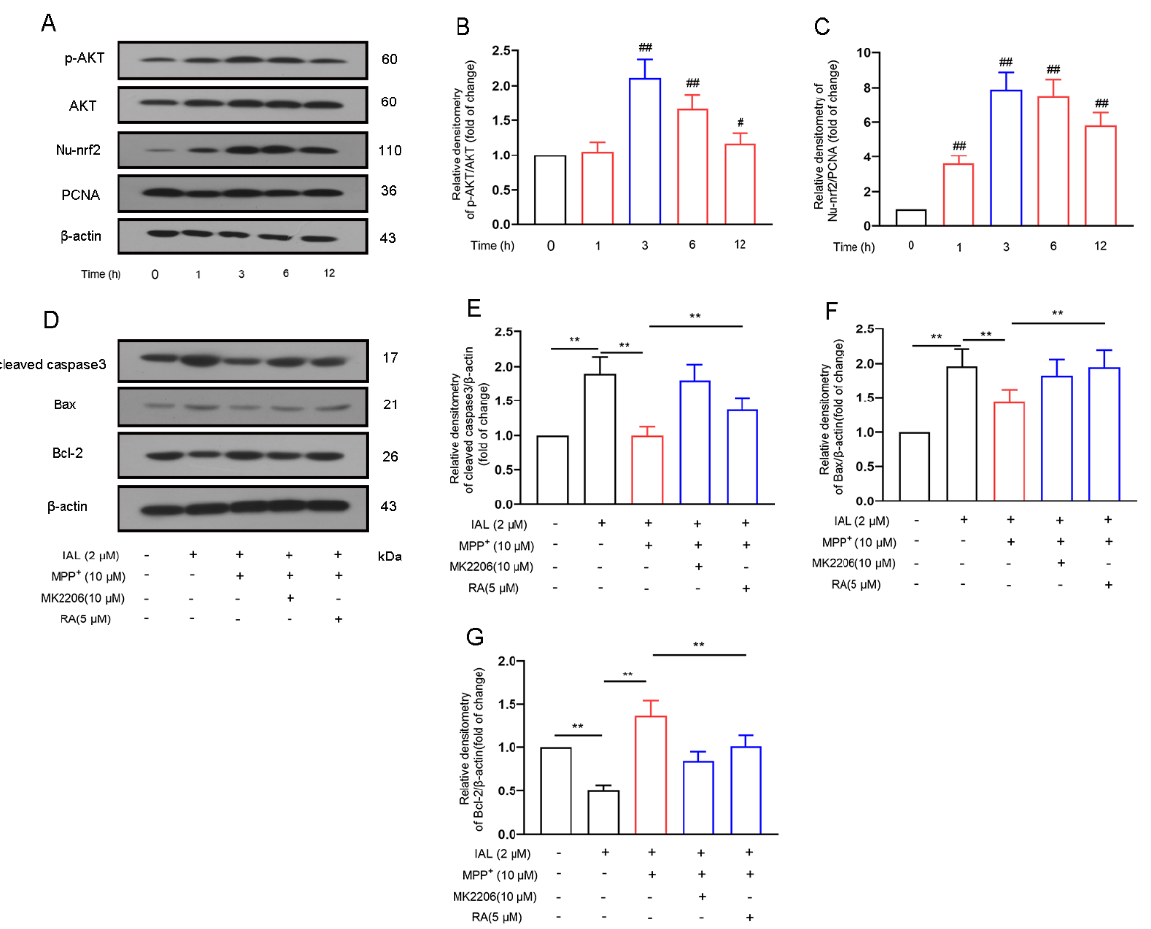
Figure 5. IAL treatment reduces MPP + -induced SN4741 apoptosis by activating AKT/Nrf2 pathway. ( A – C ) The effect of IAL on the AKT/Nrf2 pathway in SN4741 was analyzed with the Western blot method. ( D – F ) After pretreatment of cells with MK2206 and RA, the effect of IAL on apoptosis-related proteins in SN4741 was analyzed with the Western blot method. Results are shown as means ± SEM (n = 3). # p < 0.05, ## p < 0.01, and ** p < 0.01 stand for biologically significant differences.